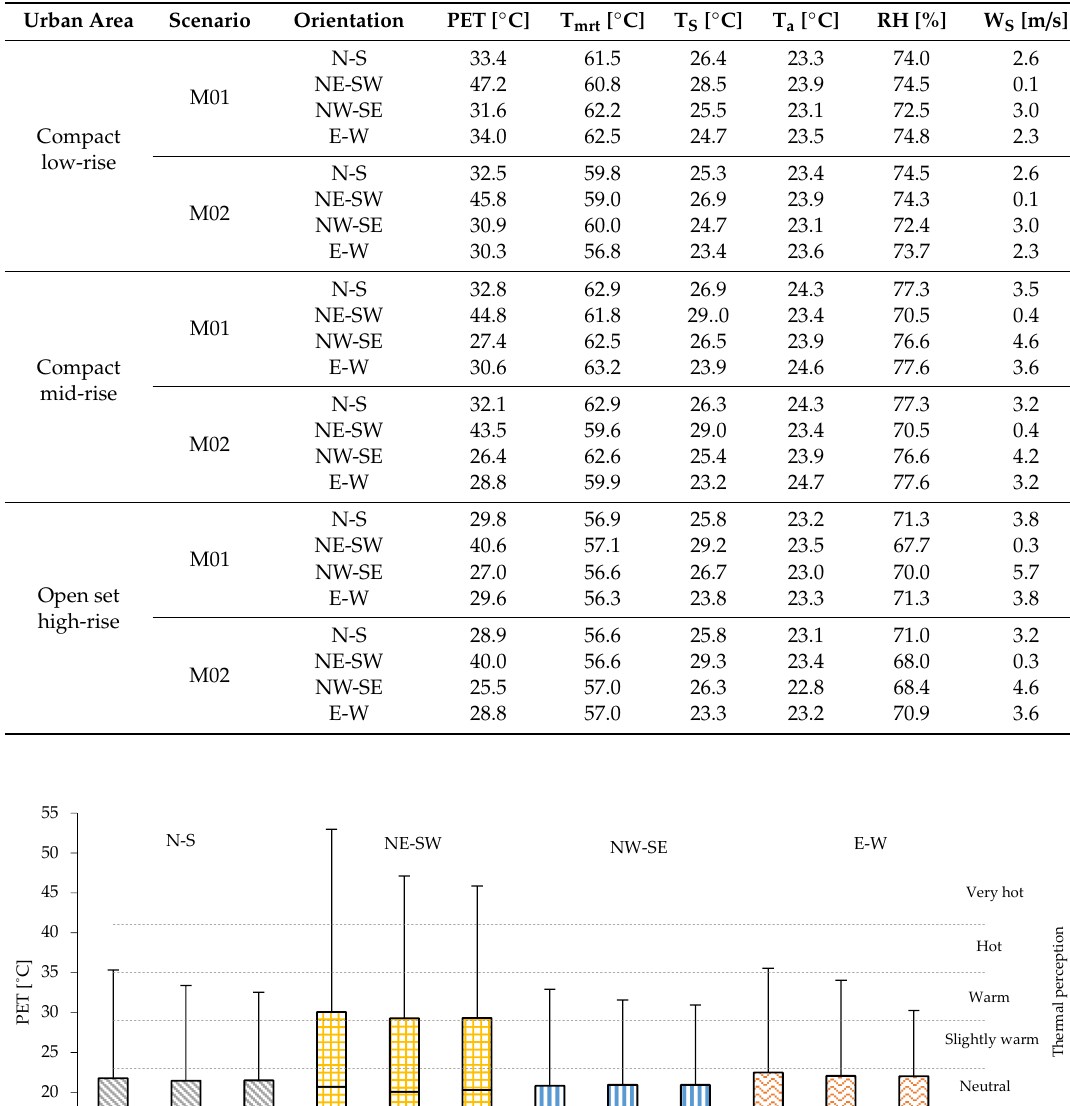
Table 13. Peak values of PET, Mean Radiant Temperature (T mrt ), Surface Temperature (T S ), Air temperature (T a ), Relative Humidity (RH) and Wind Speed (W S ). Data extracted by all 14 receptors.